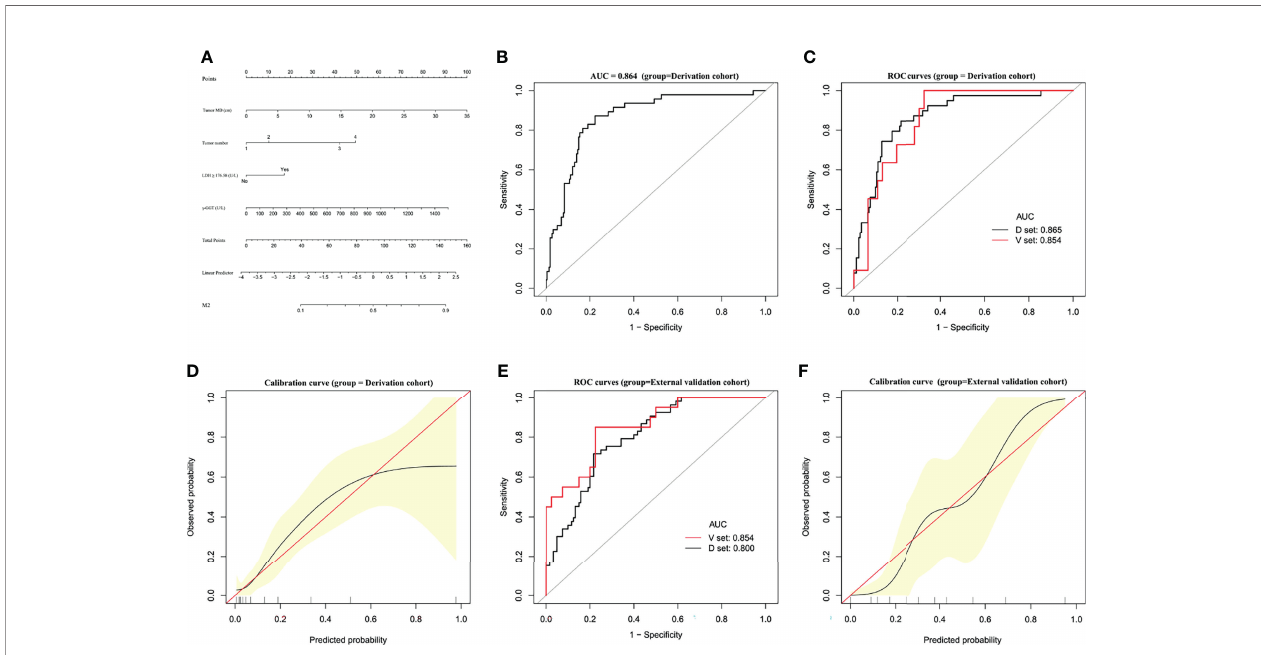
FIGURE 2 | Establishment and validation of M2 predictive nomogram for HCC patients. (A) M2 prediction scores are calculated with this four-factor nomogram by fi nding the position and corresponding y-axis point value of each variable and summing the point values of all fi ve variables, and then reading the probability on the x- axis. (B) M2 nomogram AUC = 0.864 (95% CI, 0.8081 – 0.9196). (C) Bootstrap analysis for internal validation and (D) GiViTI calibration plots showing good prediction-observation agreement for M2 in the derivation cohort. (E) Bootstrap analysis for internal validation and (F) GiViTI calibration plots showing good prediction-observation agreement for M2 in the external validation cohort. AUCs are shown in the fi gure and reported with 95% CIs in the text together with the c- index. Calibration plots (black lines) show fi tted polynomial logistic function curves of the relationship between the logit transformation of the predicted probabilities and empirical outcomes (shaded yellow, 95% CI). Ideal reference lines are red. HL chi-square calibration values for each cohort are reported in the Results